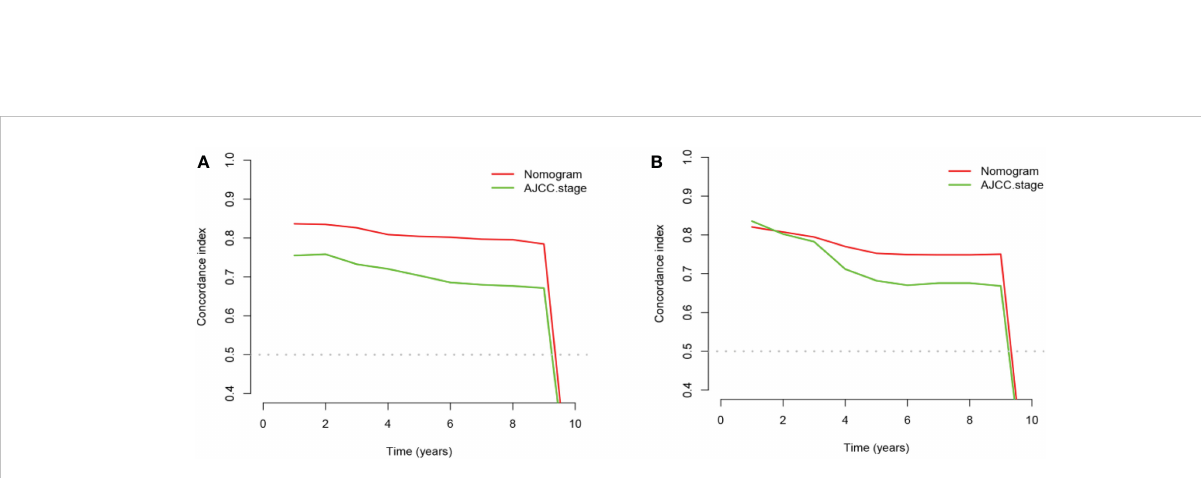
FIGURE 5 The comparison chart of C-index between nomogram and AJCC stage. (A) In the training cohort and (B) in the validation